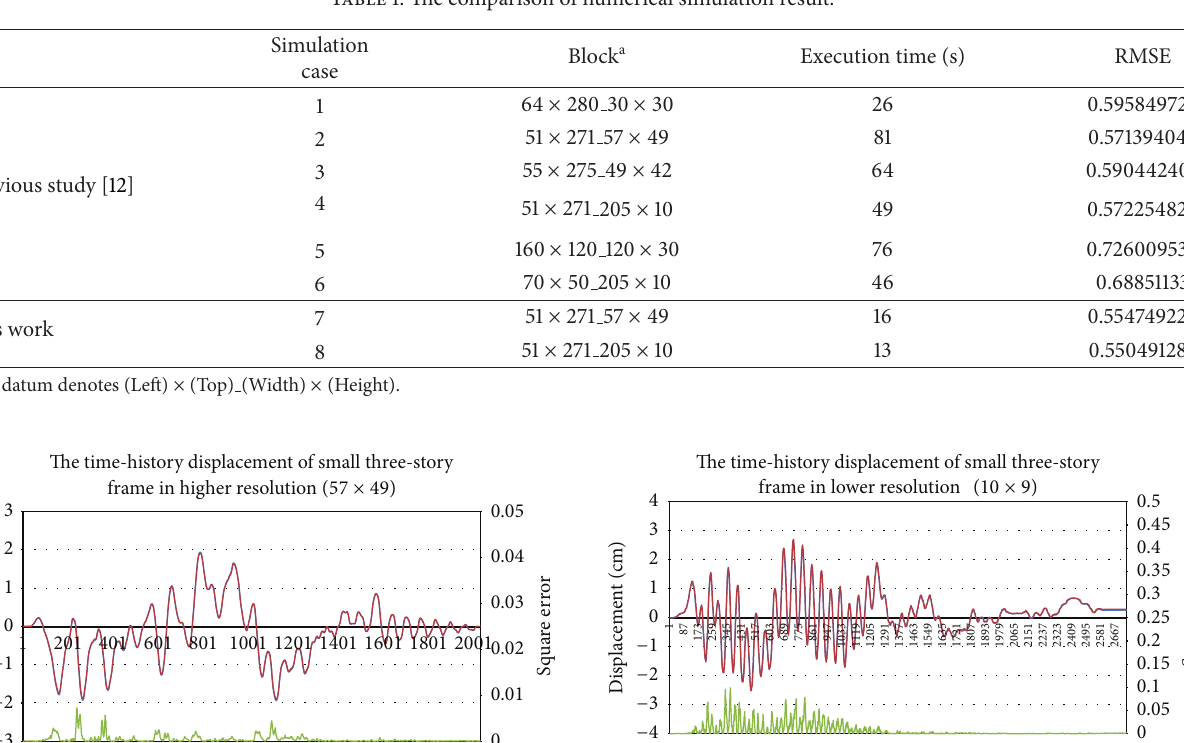
Figure 11: Patterns with different resolutions. (a) High resolution, 57 × 49. (b) Low resolution, 10 × 9. Table 1: The comparison of numerical simulation result.